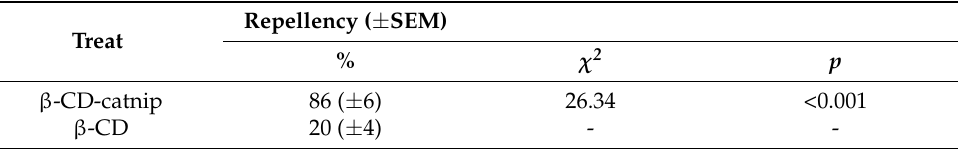
Table 4. Mean percentage ( ± SEM) of ticks repelled by β -cyclodextrin-catnip complex in vertical bioassays ( n =